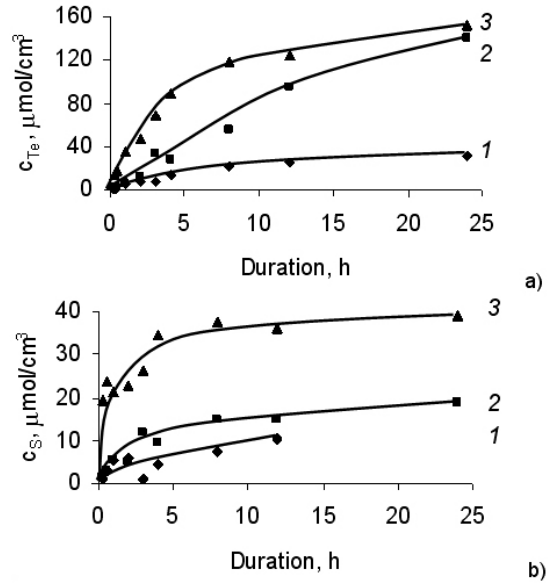
TeS O solution. 2 4 6